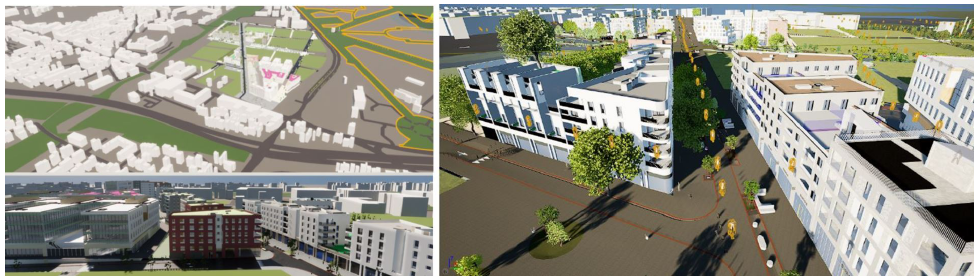
Figure 1. LaVallée district: location in the city and point of views of the large-scale immersive